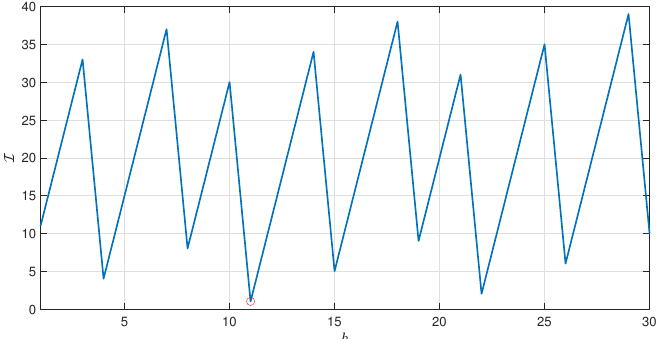
Figure 2. Set I representing the minima of ( z j ) j ≥ 0 when a = 91 and n = 131.